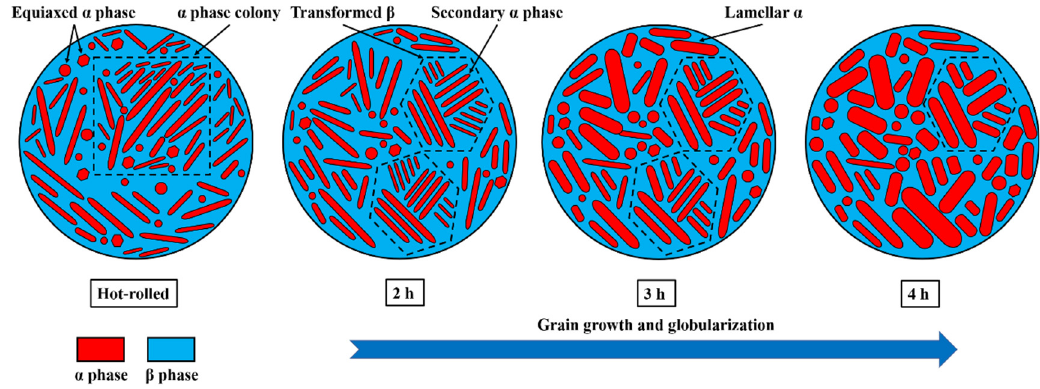
Figure 5. Microstructure evolution of TC4 alloy aged sheets.